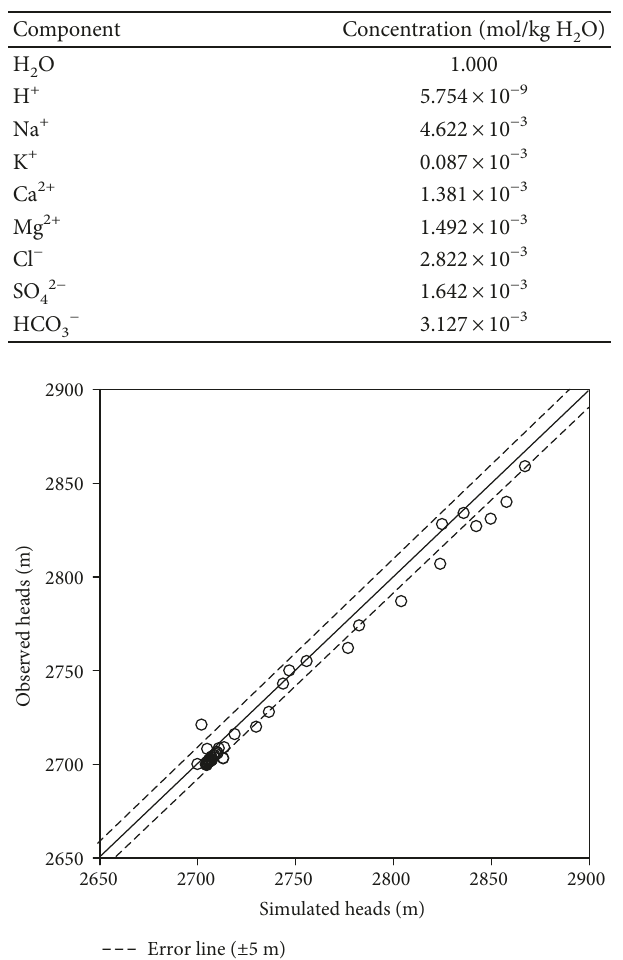
Figure 4: Schematic diagram of the model mesh. Table 3: Initial component concentrations of the model.